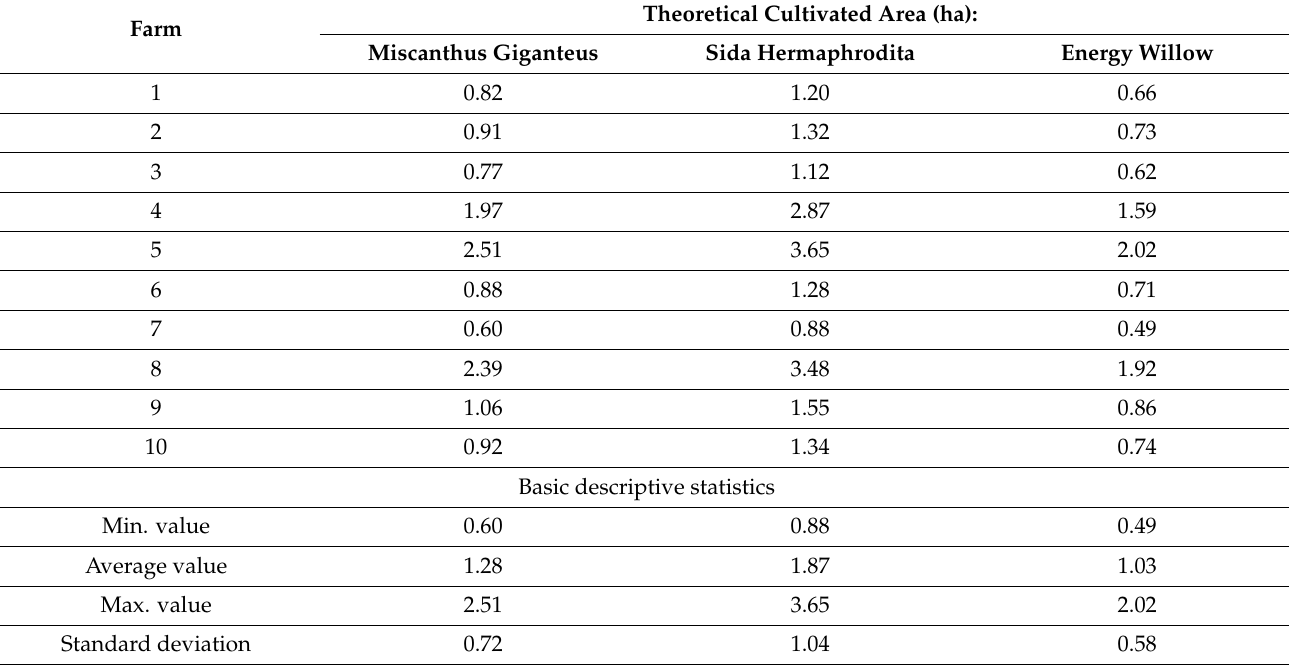
Table 6. Theoretical area of cultivation of selected energy